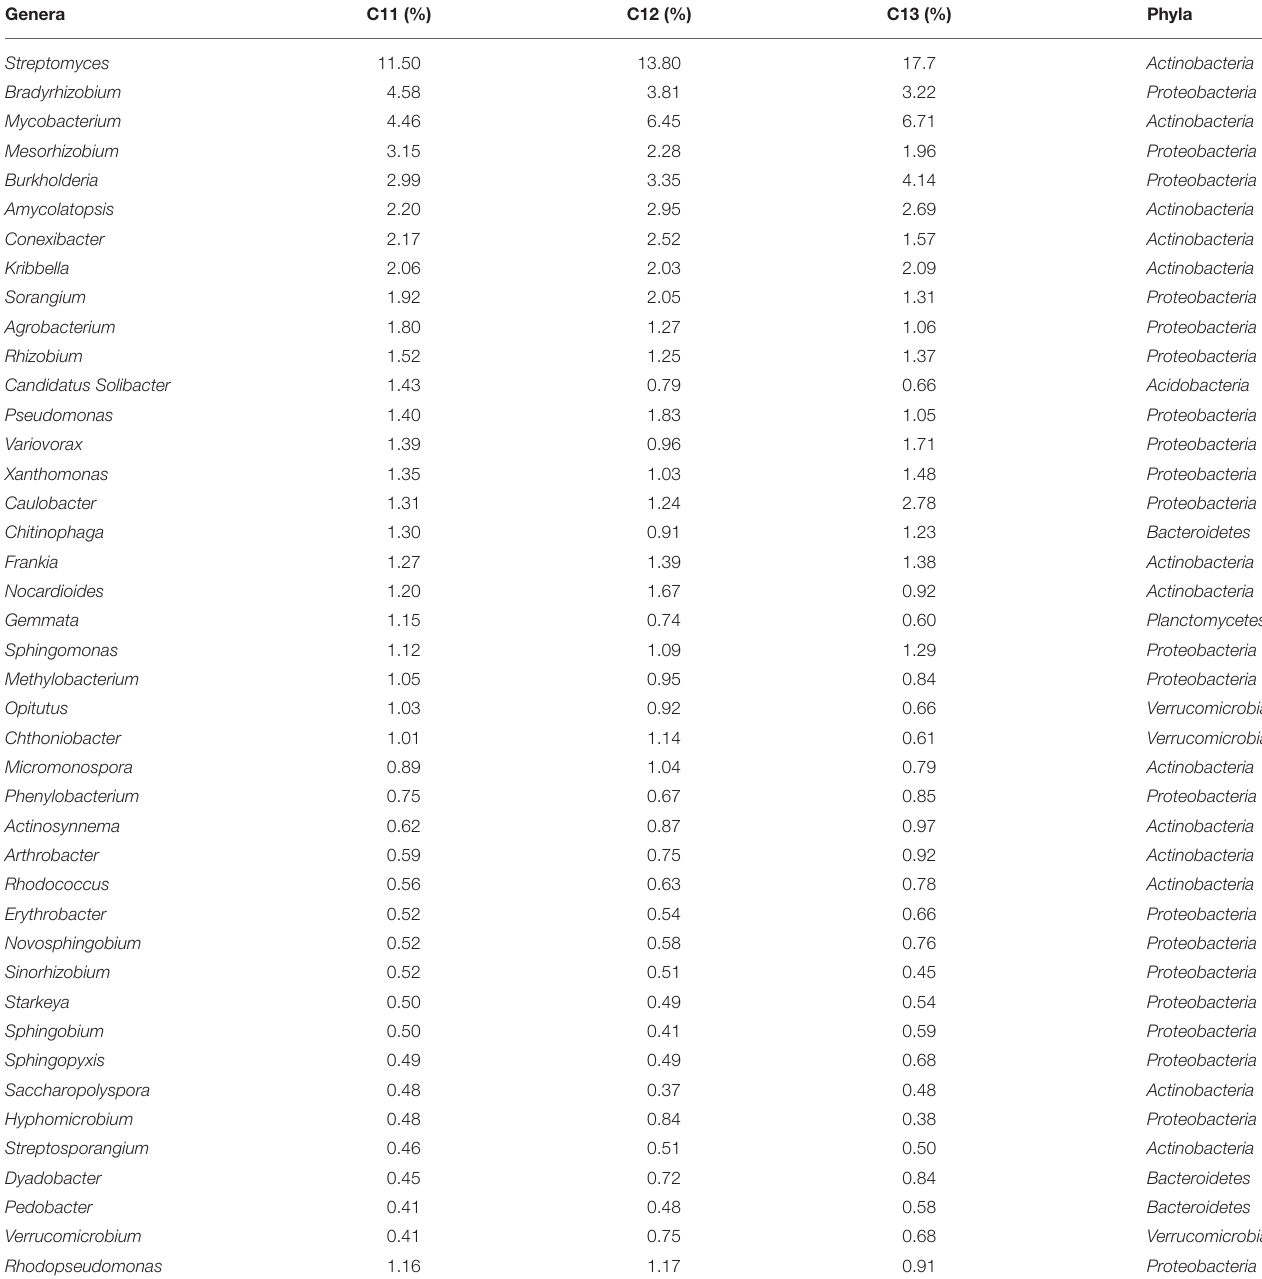
TABLE 3 | Core microbiome of Kishtwar analyzed in 3 years (42 genera) in C11, C12, and C13 with their relative abundance